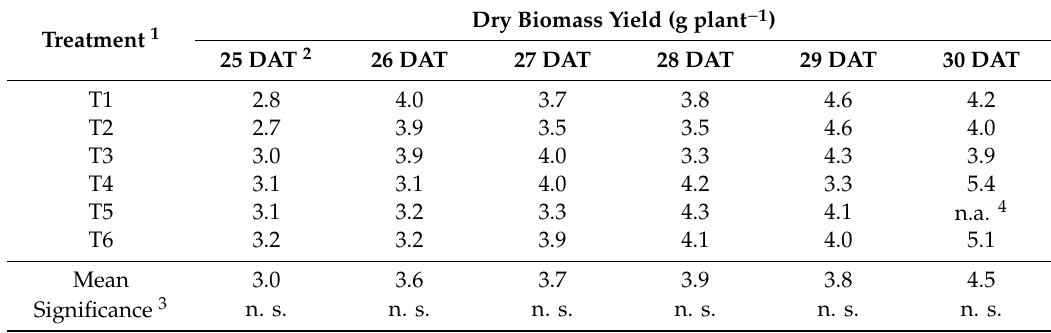
Table 3. Autumn trial: dry biomass yield of lettuce per type of fertilization treatment. Treatment